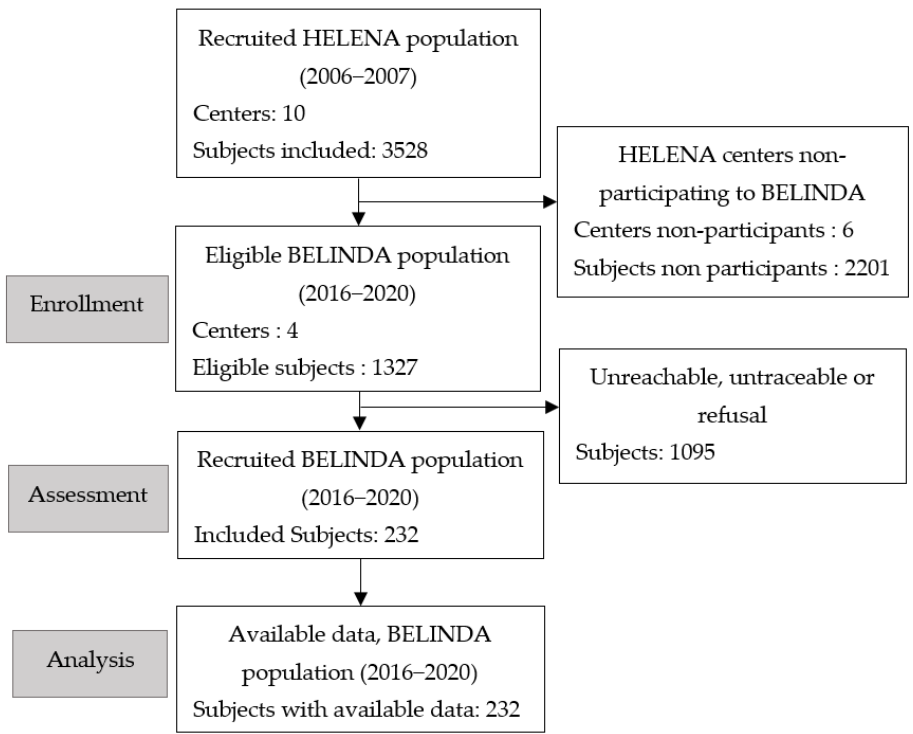
Figure 1. Flow diagram of the BELINDA study recruitment process. Shadow corresponds to the inclusion steps. Table 5. BELINDA population detailed by investigation center.